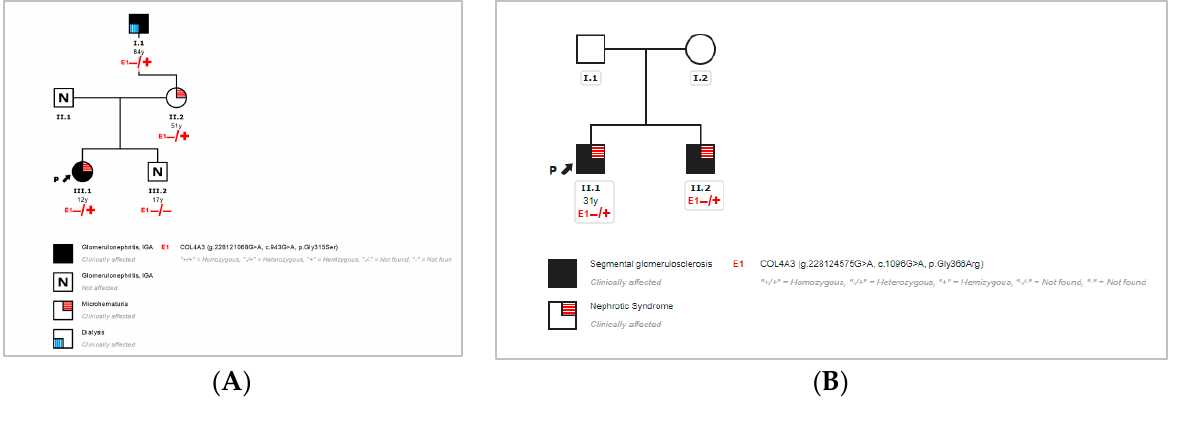
Figure 4. Pedigree of case 1 ( A ) and pedigree of case 2 ( B ).